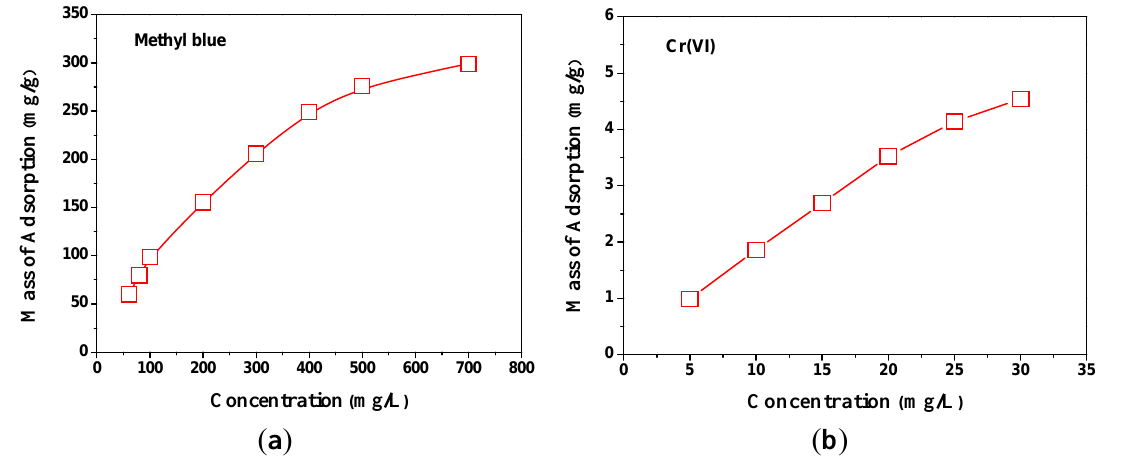
Figure 8. The adsorption isotherms for methyl blue ( a ) and Cr(VI) solution ( b ) by PVI-TFSI.